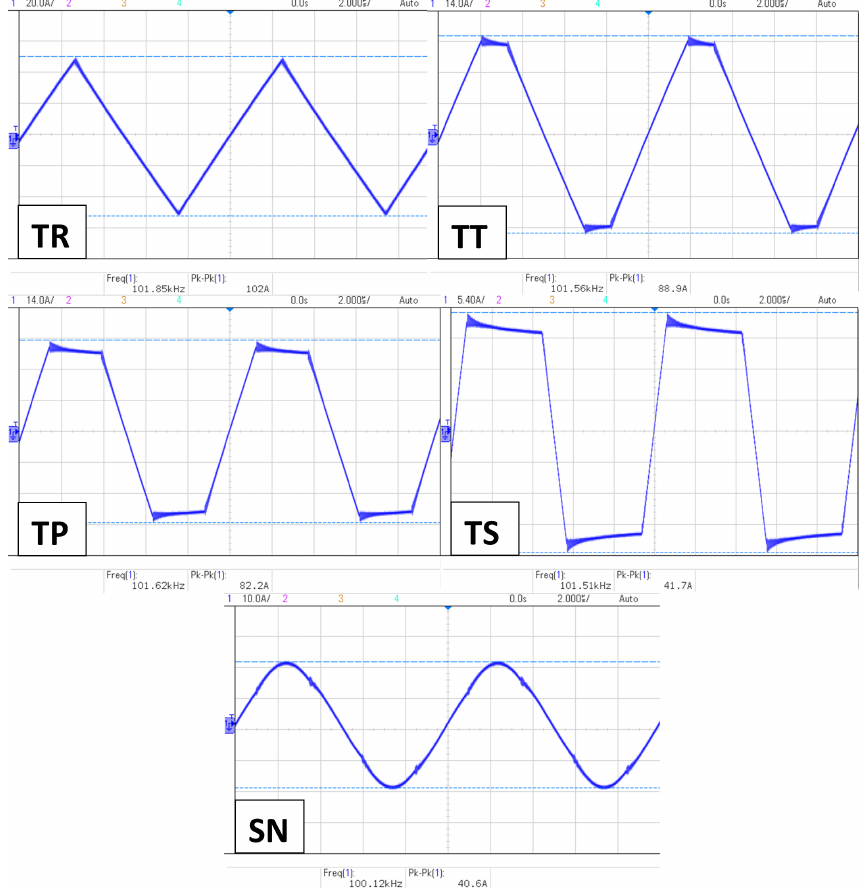
Figure 2. AMF generator